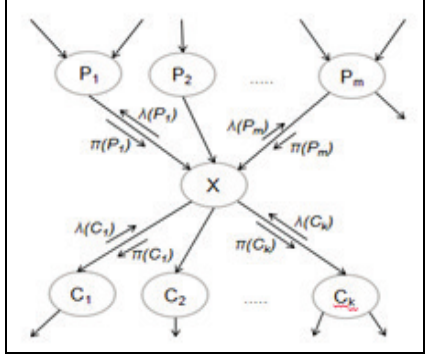
Fig.5. Messages’ propagation in Pearl’s inference